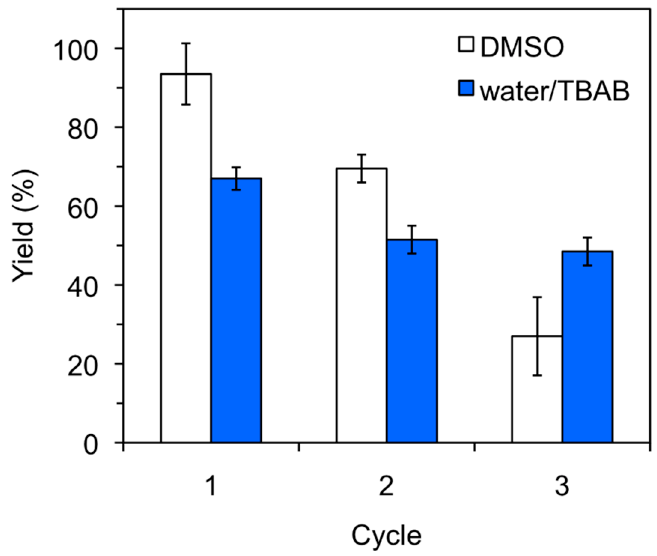
Figure 1. Typical recycling experiments for keratin-catalyzed nitroaldol (Henry) reaction in DMSO and H 2 O/TBAB. Reaction conditions: 4-Nitrobenzaldehyde ( 1a , 15.1 mg, 0.1 mmol), nitromethane ( 2a , 54 μ L, 1.0 mmol), solvent (0.5 mL), keratin powder (10 mg), room temperature, 24–48 h. Yields correspond to 1 H-NMR values obtained from at least two experiments. The error bars represent the standard deviation of the measurements. For the experiments in H 2 O/TBAB, addition of new TBAB after each cycle (i.e., 32.2 mg, 0.1 mmol) was necessary in order to ensure a constant concentration during the reactions as confirmed by NMR analyses of the reaction mixtures.